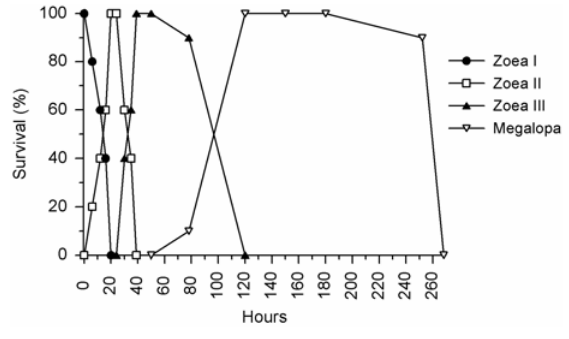
Fig. 4 – Survival (%) and intermoulting period (hours after hatching) of Lepidophthalmus siriboia larvae reared in the laboratory and sub- mitted to an initial feeding period. In this treatment, they were fed during 3